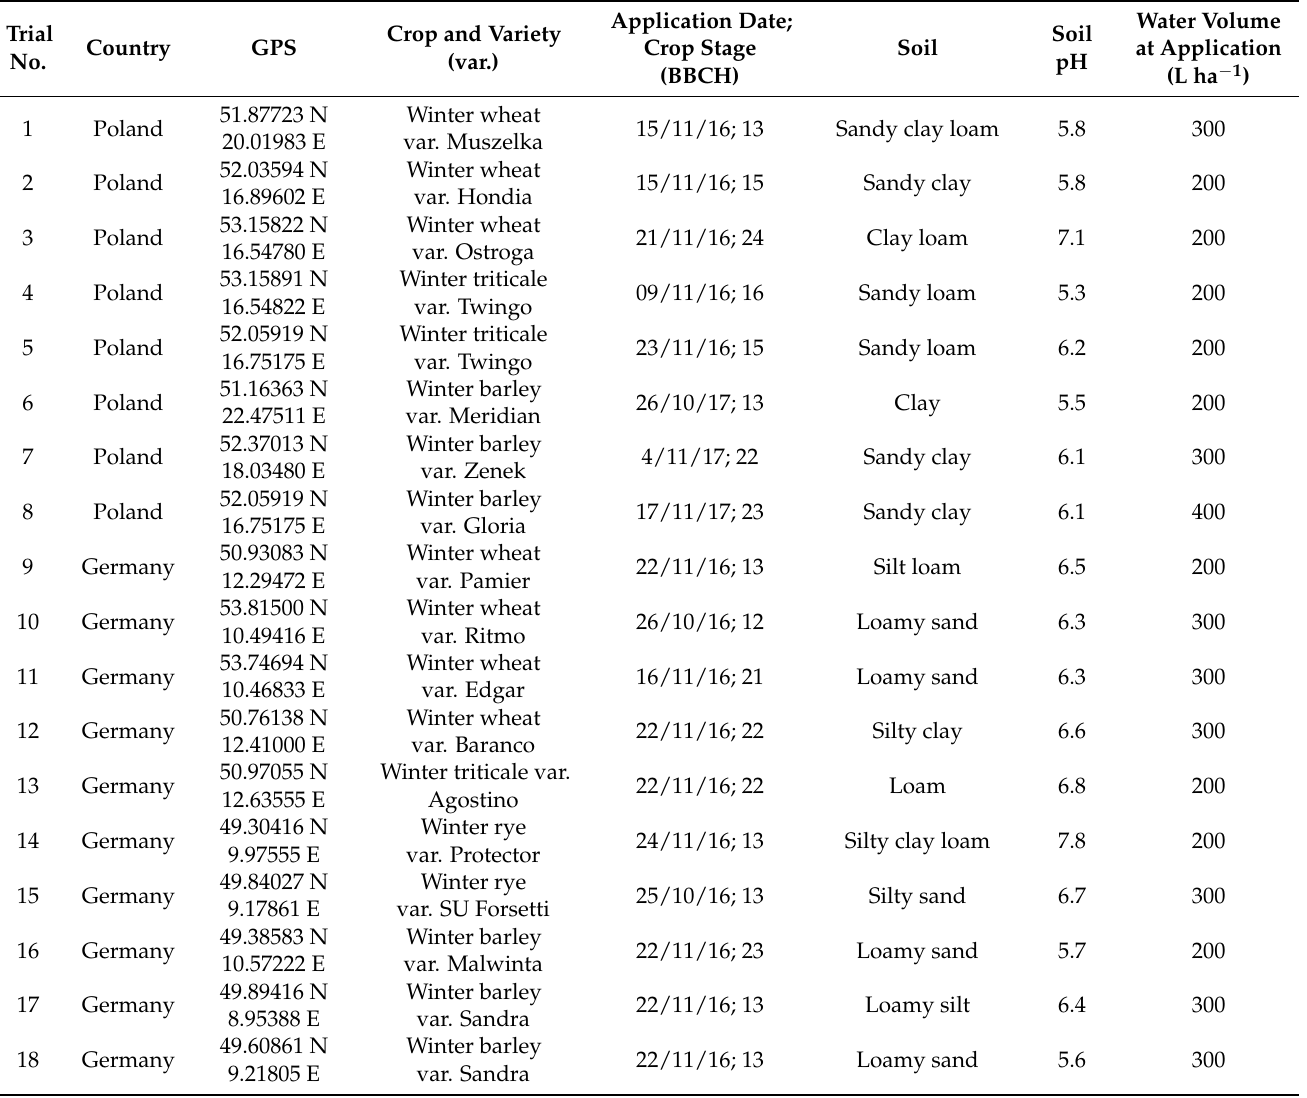
Table 1. Experimental site descriptions and application details are